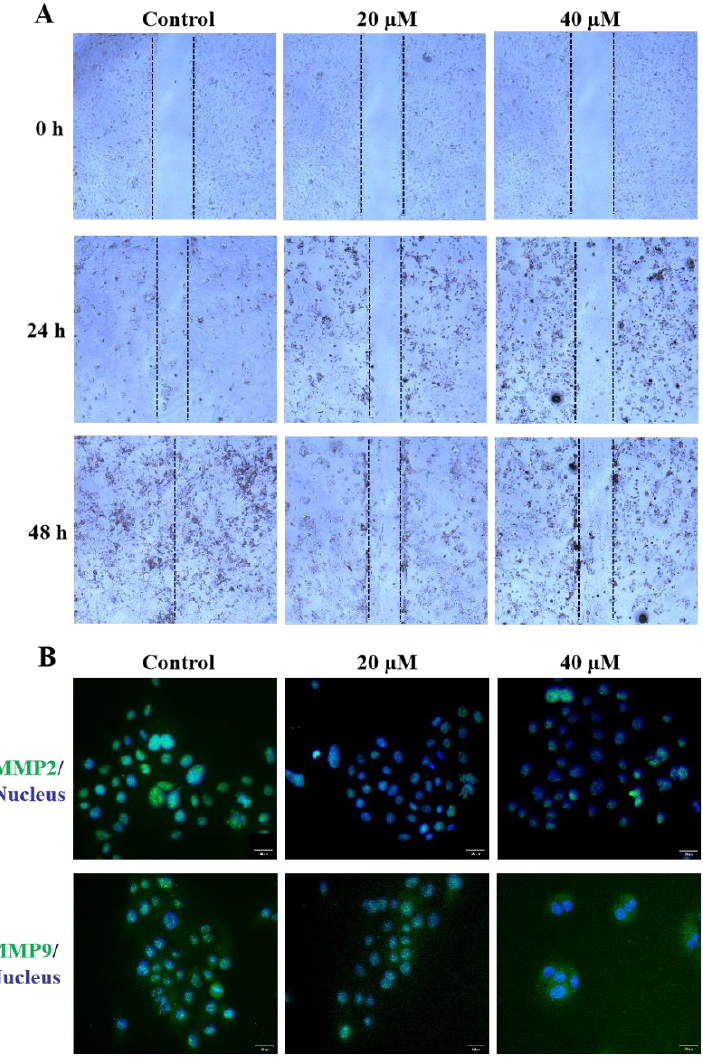
Figure 3. Effects of G-6 on in vitro SW1990 cells migration. ( A ) Effect of G-6 on the wound healing assay of SW1990 cells. Cells were seeded into six-well plates and treated with different concentrations of G-6 for 24 h and 48 h. ( B ) Representation of immunofluorescent images of SW1990 cells treated with DMSO or G-6 at various concentrations for 24 h. SW1990 cells were stained with MMP2 or MMP9 (green), and DNA (blue). Overlapping localization is shown in the merged images.